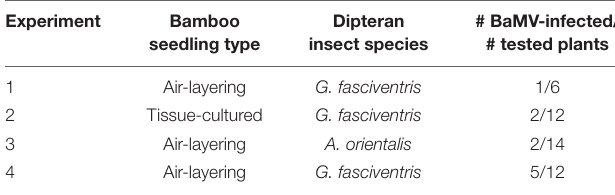
TABLE 3 | Summary of insect transmission assays on